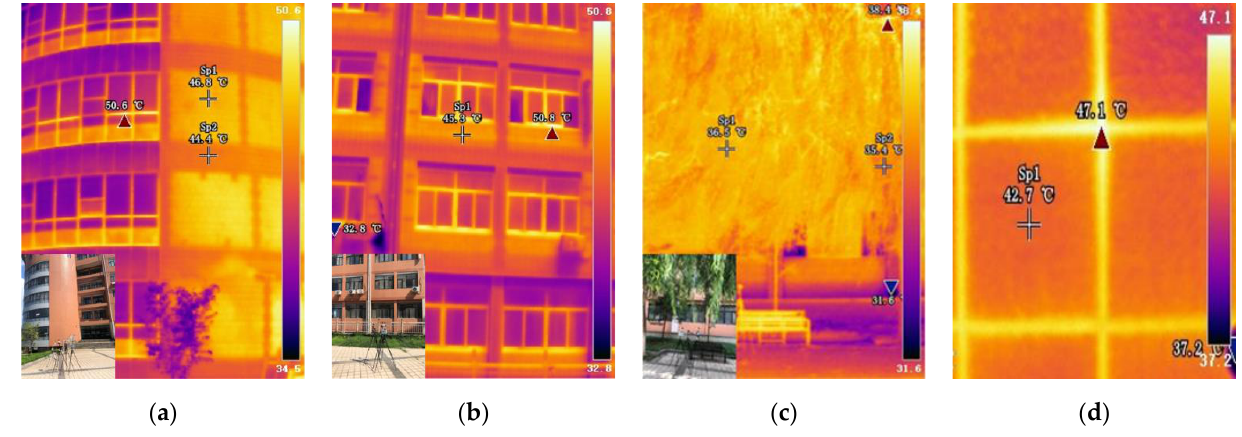
Figure 7. Results of the thermography carried out at 12:00. ( a ) Point 1; ( b ) Point 2; ( c ) Point 3; (d) ground.